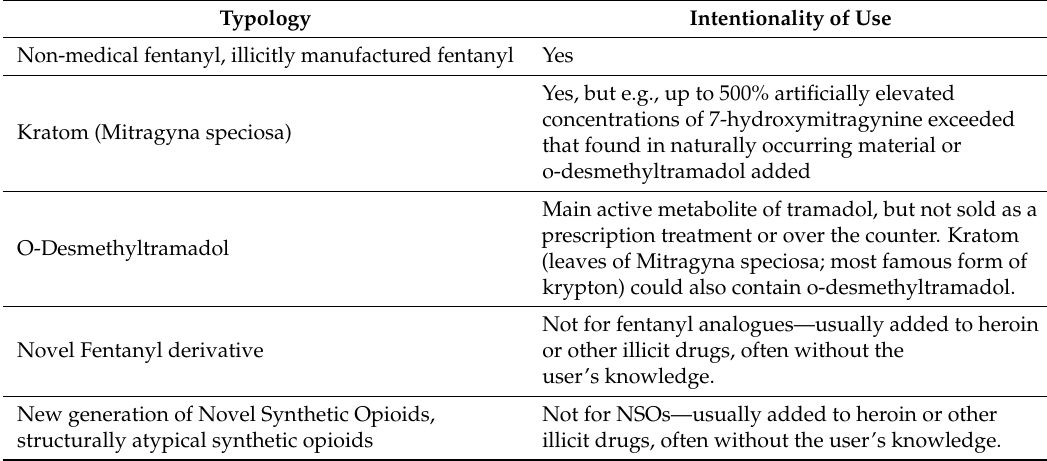
Table 3. Common characteristics of NSOs: intentionality of